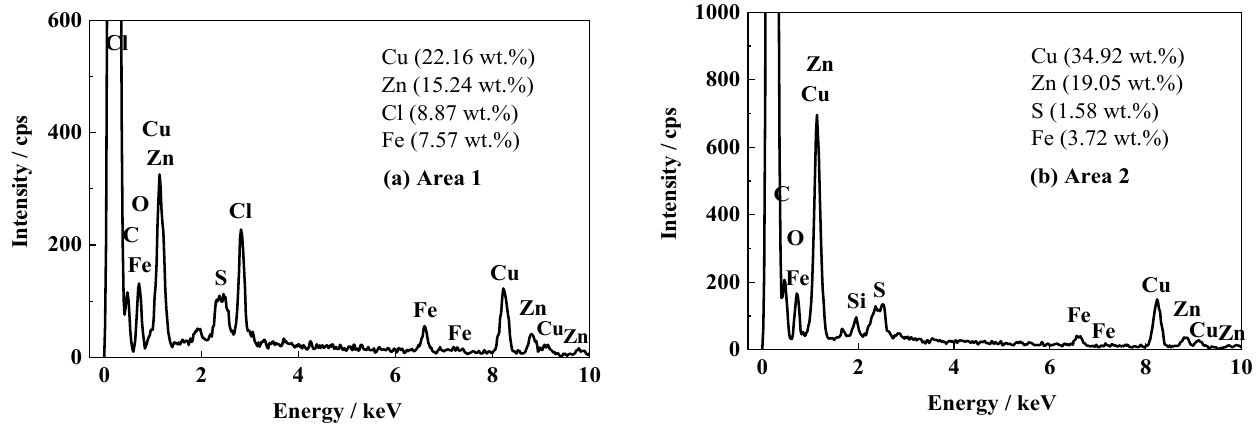
Figure 7. EDS results of FW2 antifouling coating after 1700 d: ( a ) cross-sectional leached layer of topcoat; ( b ) cross-sectional inner layer of topcoat.